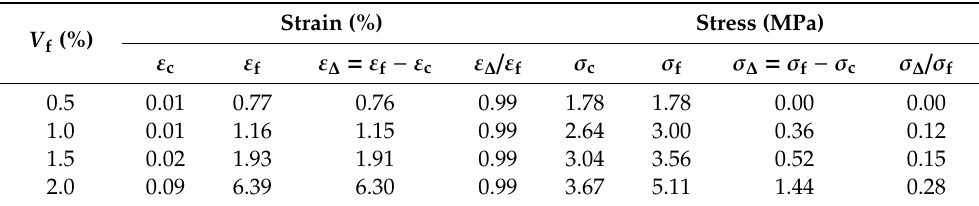
Table 6. Strain and stress of PVA-FRCM under uniaxial